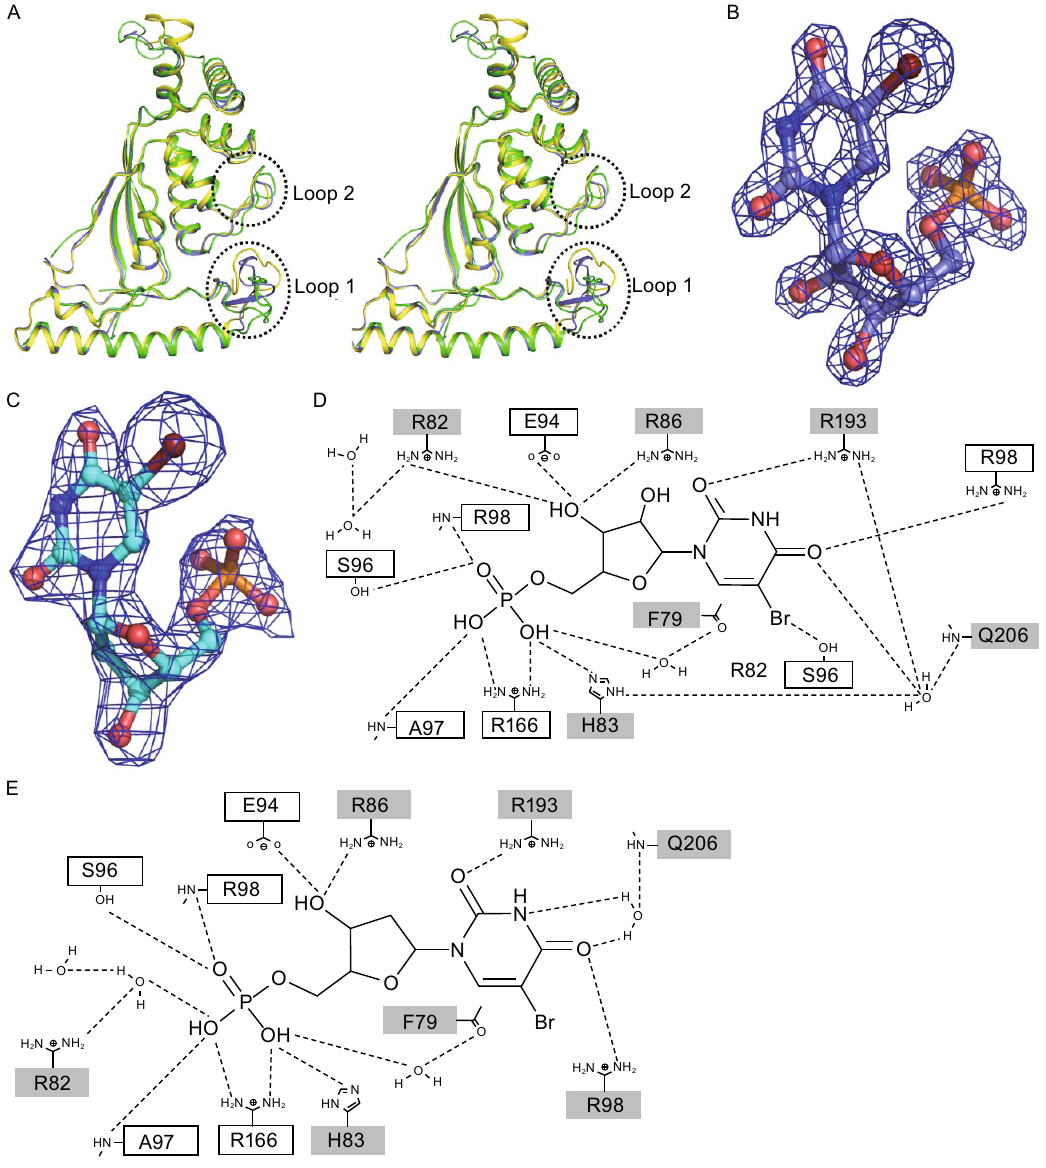
Figure 5. Comparison of two structures of PolB complex. (A) Superposition of structures of PolB (green), PolB/5-Br UMP (blue) and PolB/5-Br UMP (yellow). The N-and C-terminus are indicated. (B) and (C) Electron density for 5-Br UMP and 5-Br dUMP respectively. The 2 F o - F c map is contoured at 2.0 σ . (D and E) Schematic representations of the interactions between the active site residues of PolB and (D) 5-Br dUMP or (E) 5-Br UMP. The hydrogen bonds were labeled as dashed lines. Residues in the white and grey box are from two separate